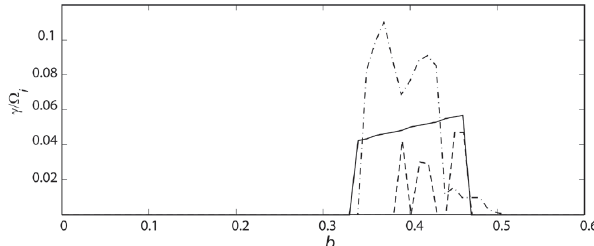
Fig. 5. Behavior of the IEDD solutions shown in Fig. 3 for ω r = 0 . 98 with varying u : the dashed line refers to u = 0 . 05, dashed- dotted line to u = 0 . 1, and solid line to u = 0 .